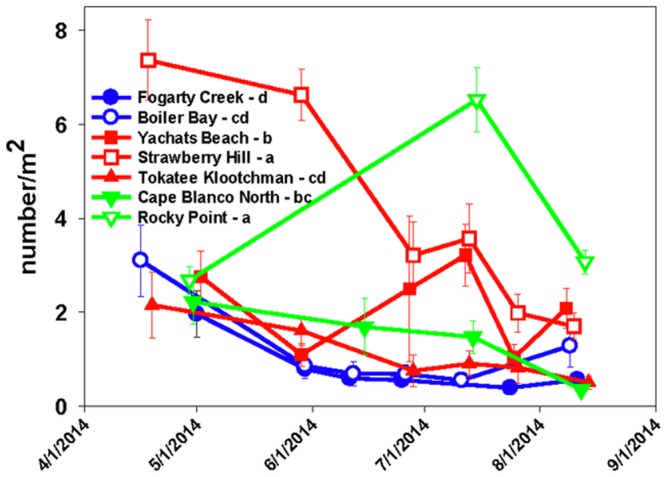
Decline in adult and juvenile P. ochraceus density, spring and summer 2014, at six sites.Differences in overall average densities (ln-transformed data in a 2-way ANOVA testing site and month without interaction term) are shown by lower case letters in legend, where sites sharing the same letter were not different at p > 0.05.